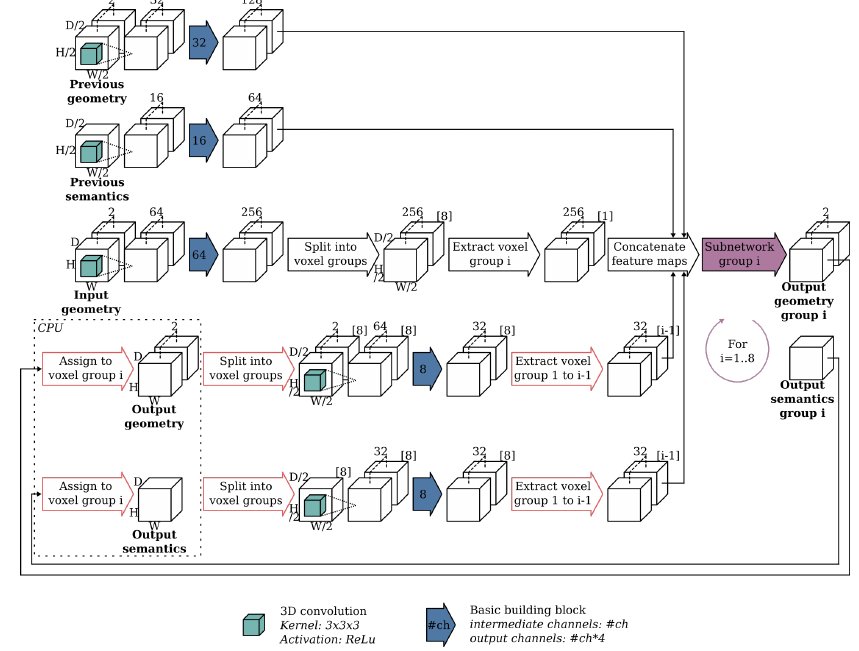
Figure 3. Overview of the baseline 3D CNN for a single hierarchy. Note that for the first hierarchy (19 cm) there are no previous predictions. The blue arrows represent the basic building block as shown in Figure 4. For each basic building block, the parameter value is displayed that represents the number of channels used by the 3D convolutions from the basic building